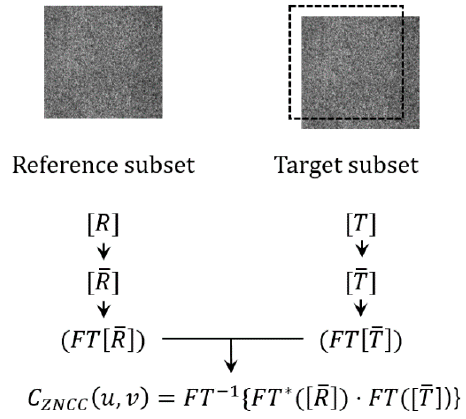
Figure 2. The correlation comparison procedure with FFT images.